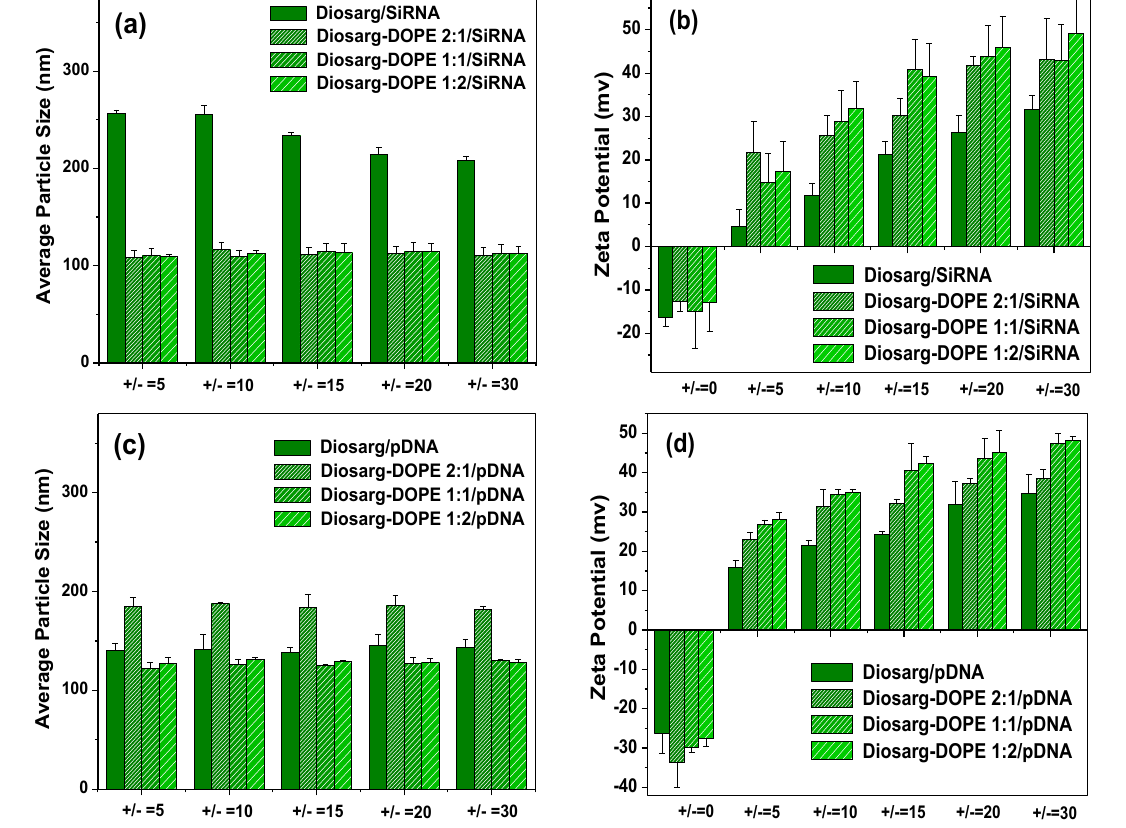
Figure 3. Average particle sizes and zeta potentials of the Diosarg/siRNA and Diosarg-DOPE NPs/siRNA ( a , b ), as well as the Diosarg/pDNA ( c ) and Diosarg-DOPE NPs/pDNA ( d ) complexes under the +/− charge ratios from 0 to 30 determined by DLS.